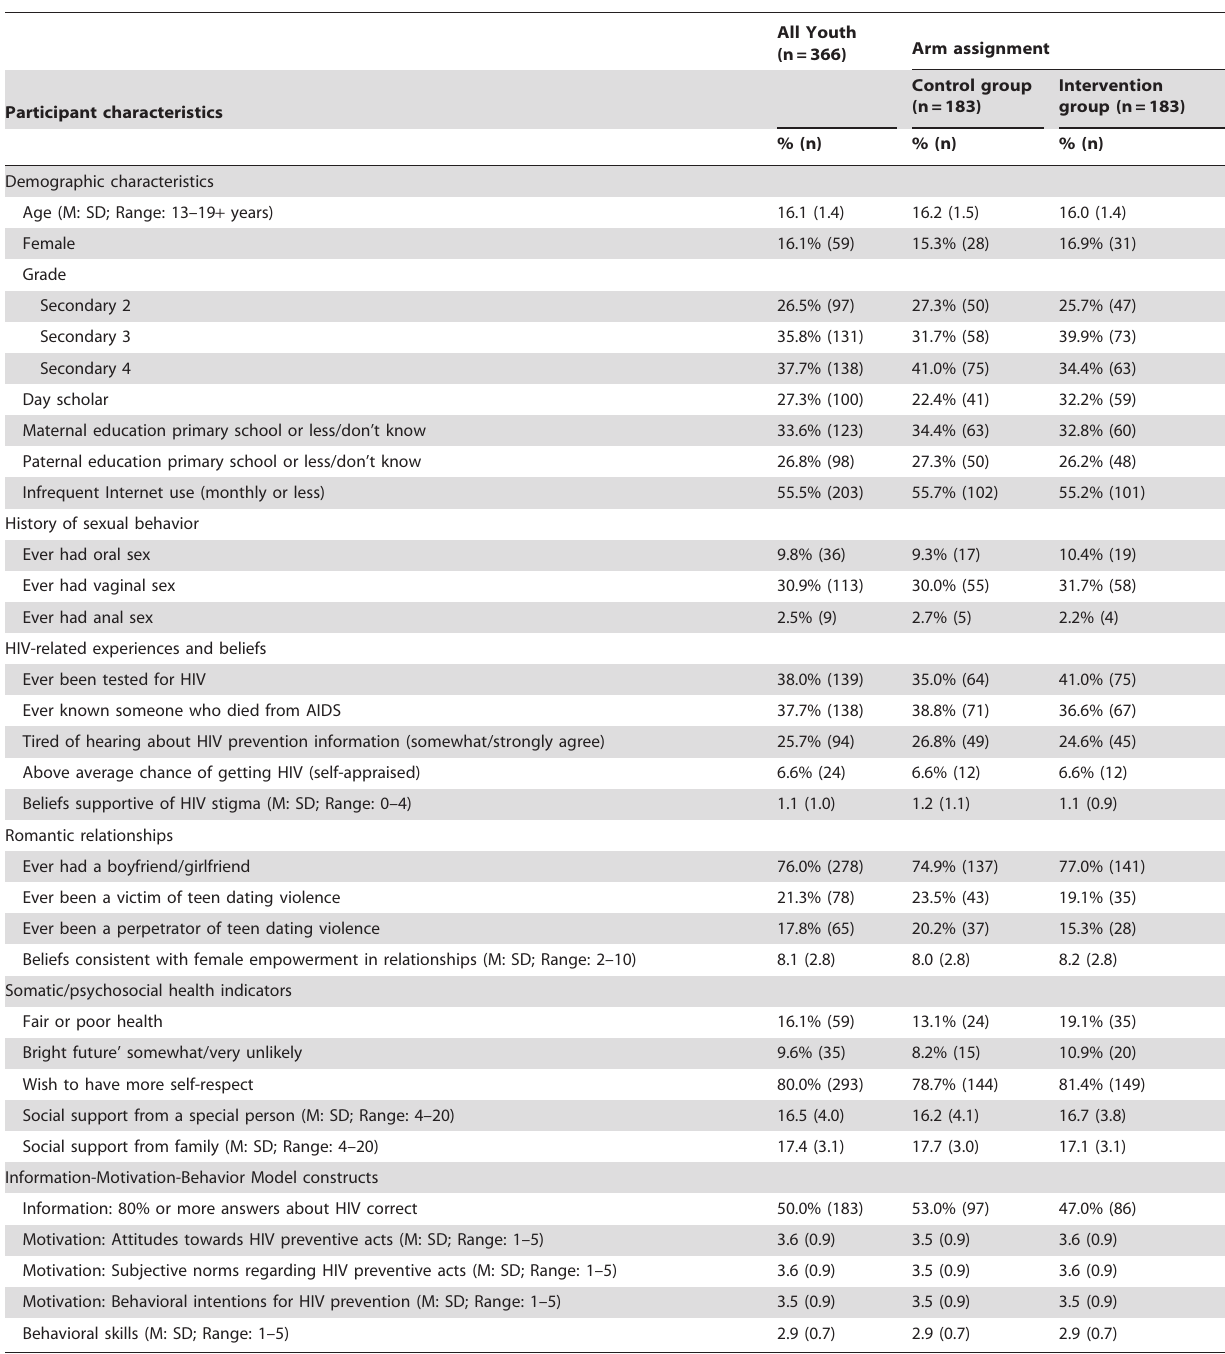
Table 2. Participant sample characteristics by arm assignment (n=